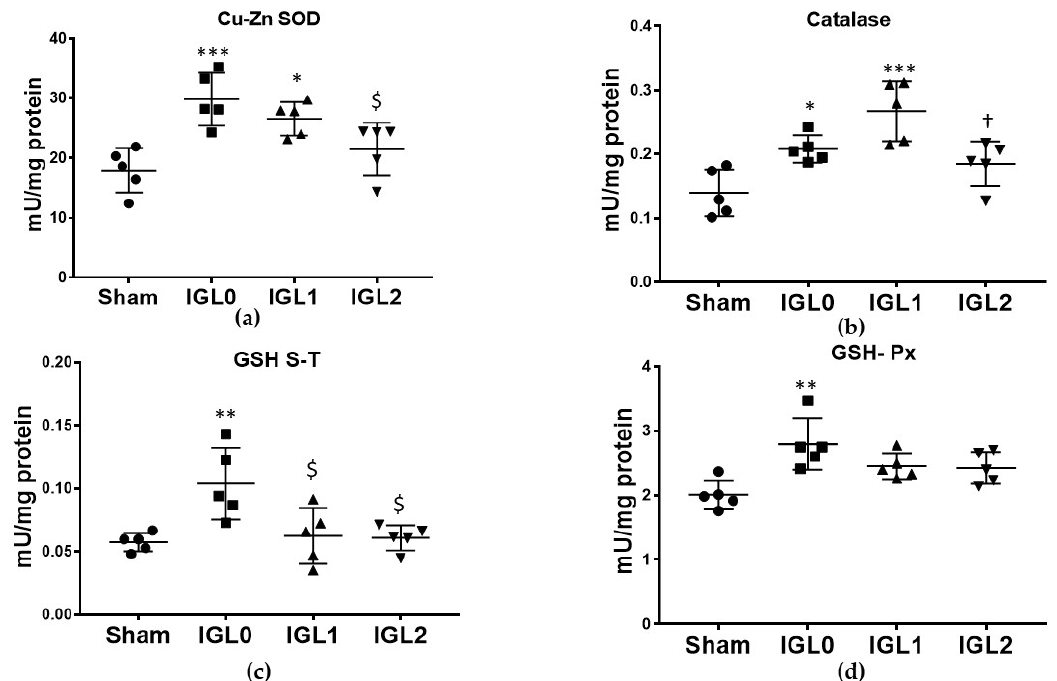
Figure 6. Enzymatic antioxidant capacity in steatotic livers preserved (4 °C, 24 h) in the IGL-0, IGL-1, and IGL-2 solutions vs. Sham: ( a ) superoxide dismutase (Cu–Zn SOD) expressed in mU/mg of total protein; ( b ) catalase expressed in mU/mg of total protein; ( c ) glutathione S-transferase (GSH S-T) expressed in mU/mg of total protein; ( d ) glutathione peroxidase (GSH-Px) expressed in mU/mg of total protein. The bars represent the mean values ± SDs of each group ( n = 5). Differences are shown comparing groups (* vs. Sham, $ vs. IGL-0, and † vs. IGL-1) according to the one-way ANOVA test and the Tukey post-hoc test (one symbol indicates p < 0.05; two symbols indicate p < 0.01; three symbols indicate p < 0.001).